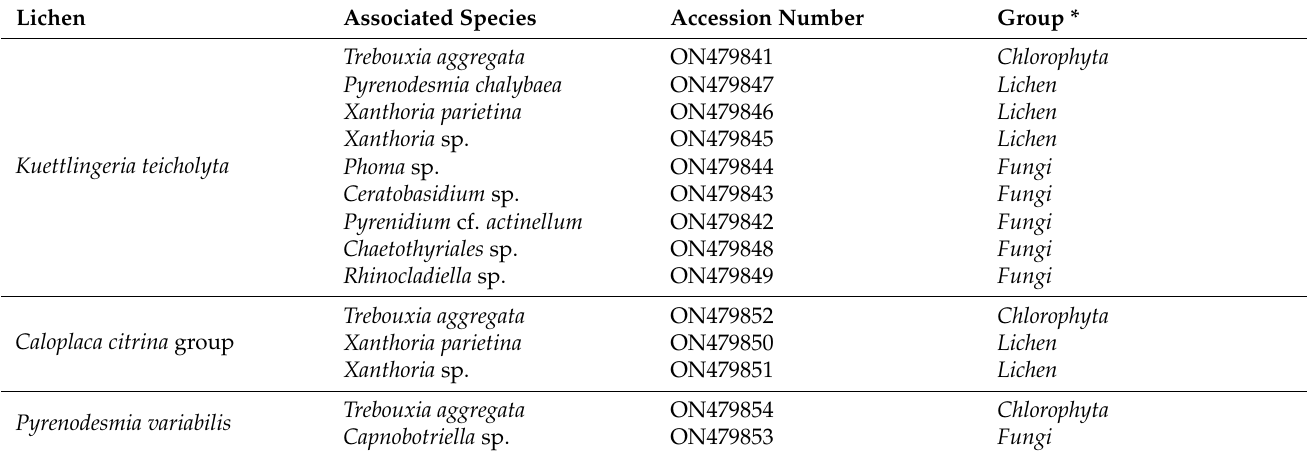
Table 2. Identification of eukaryotic organisms associated with the three main lichens colonizing the limestones from Seville City